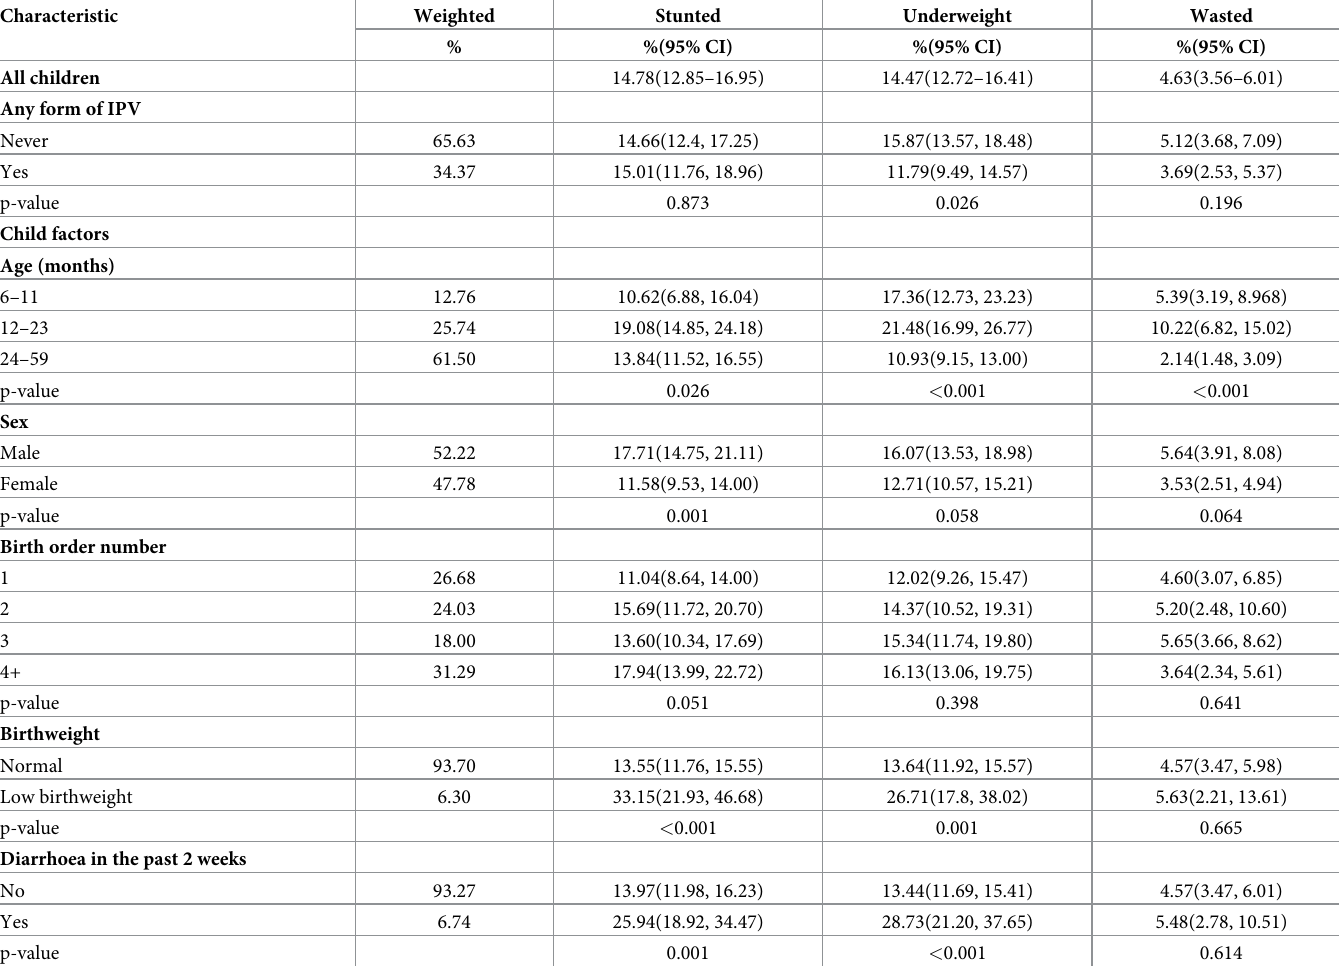
Table 3. Distribution of undernutrition among children aged 6–59 months by exposure to intimate partner violence and child’s characteristics (weighted N =